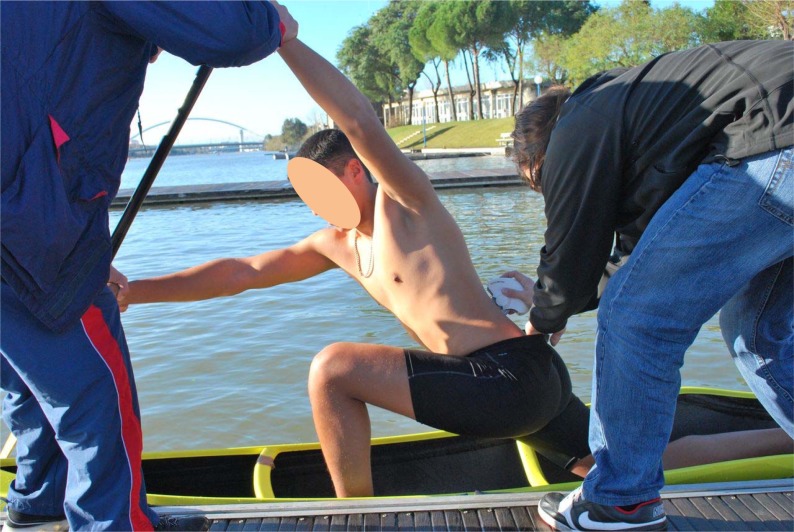
Catch phase position